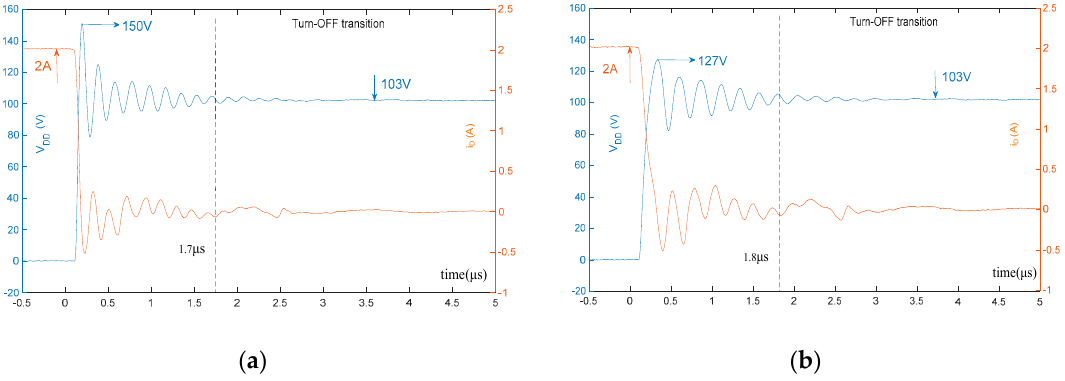
Figure 16. Turn-off transient under the condition of V in = 103 V, I L = 2.0 A, C X = 0.68 nF. ( a ) Turn-off transient without C J ; ( b ) Turn-off transient with C J of 1.0 nF.